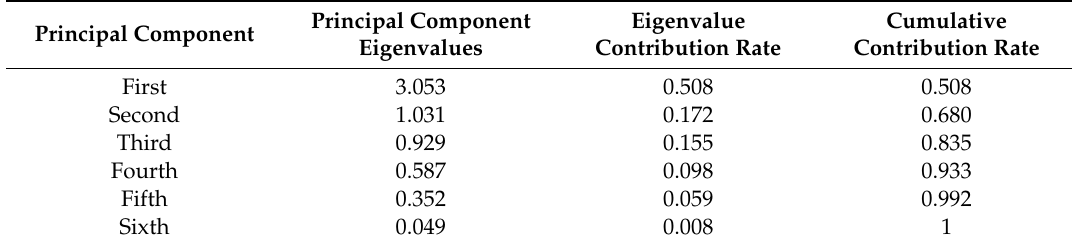
Table 1. Principle component analysis.